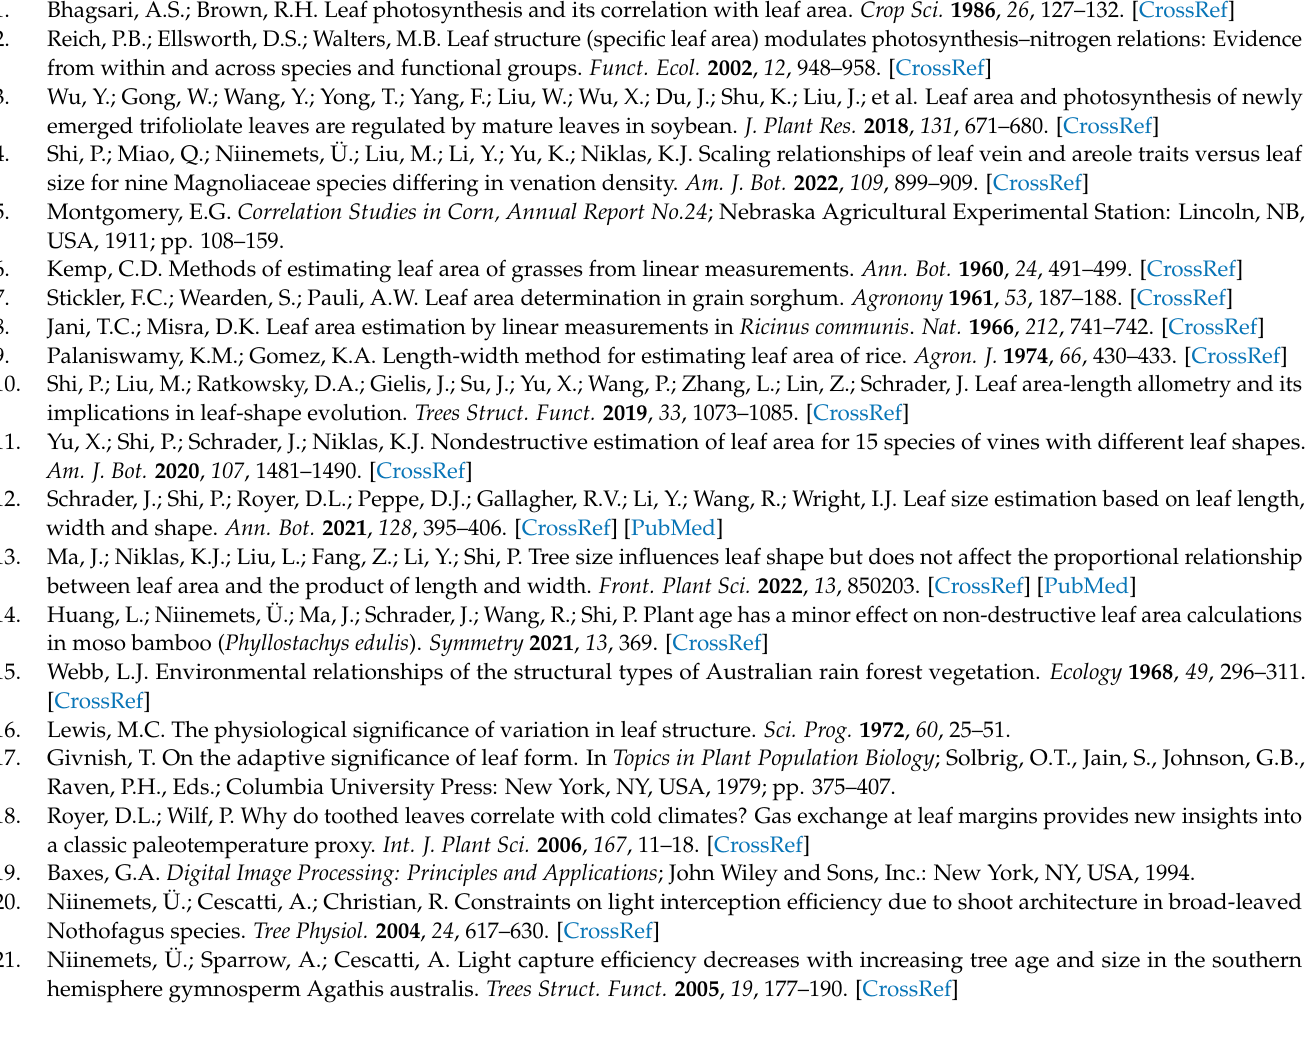
Table S2: The raw leaf data of P. serratifolia ; Table S3: Tukey multiple comparisons of the means of leaf- shape indices between any sampling months for P. × fraseri ; Table S4: Tukey multiple comparisons of the means of leaf-shape indices between any sampling months for P. serratifolia